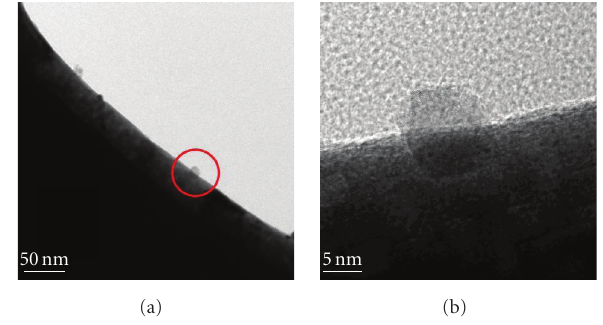
Figure 9: TEM images of NiO(0.05 wt%)/NaTaO 3 synthesized by spray pyrolysis; (b) is high magnification of circled location in the (a).